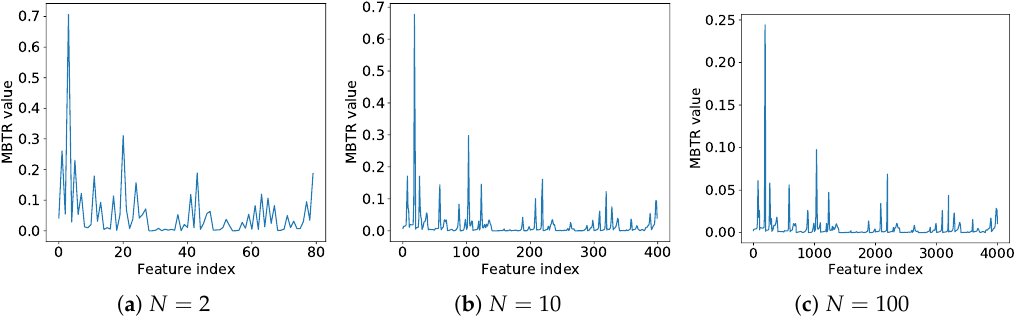
Figure A10. Means of 12,413 MBTR-K3 descriptors for grid accuracy N values 2 ( a ), 10 ( b ) and 100 ( c ). Features represent N consecutive numbers representing the angle distribution measured between groups of three atoms. The nanostructure Au 38Q is composed of four elements, hydrogen (H), carbon (C), sulfur (S) and gold (Au). The first N features are H-H-H angles, second N are H-H-C and so on. Ending with Au-Au-Au angle. There are no repeated angles and so there are a total of 40 distributions laid consecutively to form the resulting MBTR-K3